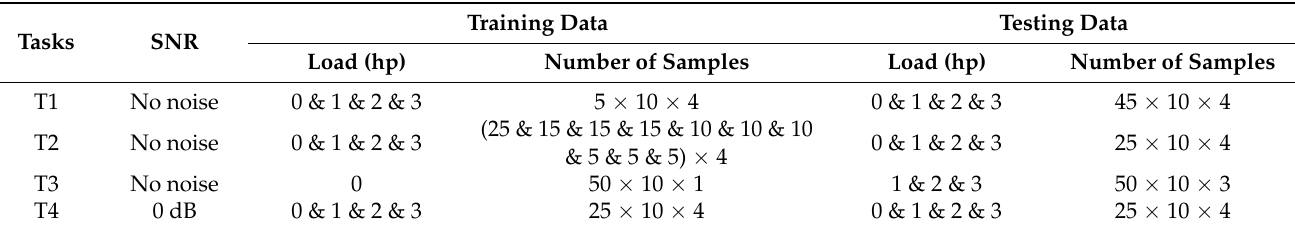
Table 8. Dataset information of four fault diagnosis